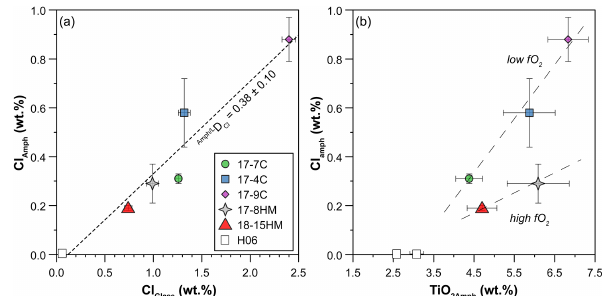
Figure 6. (a) Positive correlation between Cl content (wt%) in am- phiboles and glasses reflecting the high Cl content of the system. The dashed line is the trend line of all data (this study and the lit- erature), and its slope indicates the Amph / L D Cl . (b) Positive corre- lation between Cl and TiO 2 content (wt%) in amphiboles pointing to their interdependence, which appears to be related to f O 2 of the system. Dashed lines in (b) are a visual guide. H06: data from Hauri et al.